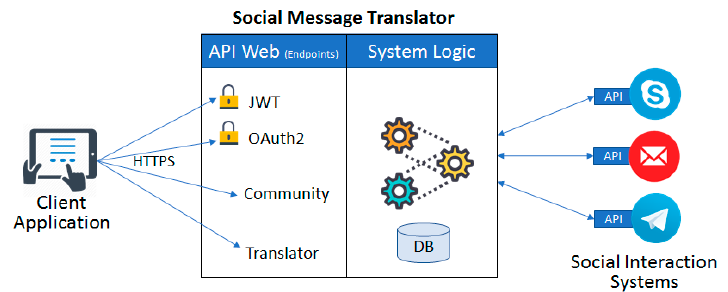
Figure 2. Structure of the Social Message